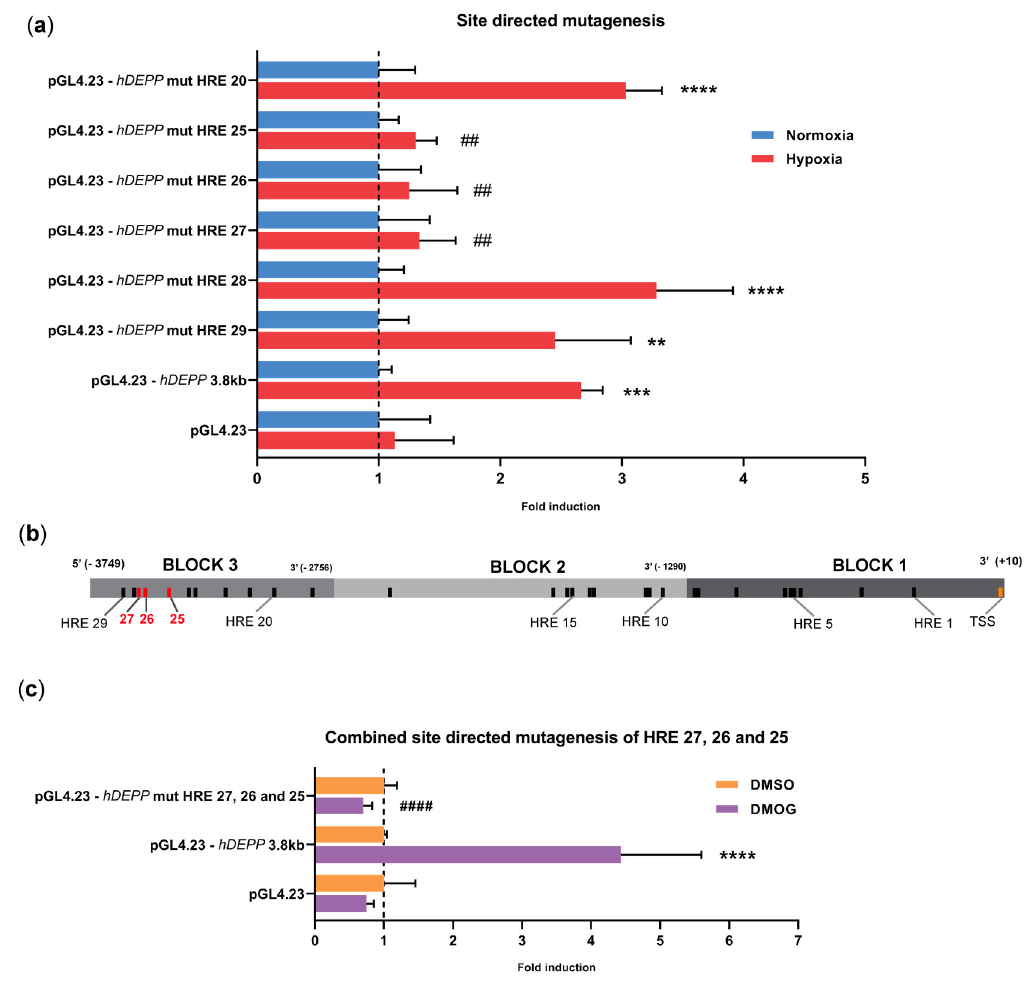
Figure 4. Identification of three functional HREs for DEPP hypoxic regulation. ( a ) Luciferase activity of cells transfected with the reporter plasmid containing the wt or the mutated 3.8 kb DEPP